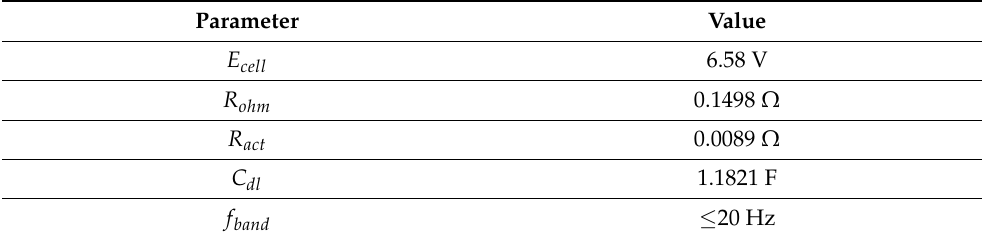
Table 1. Electric modeling